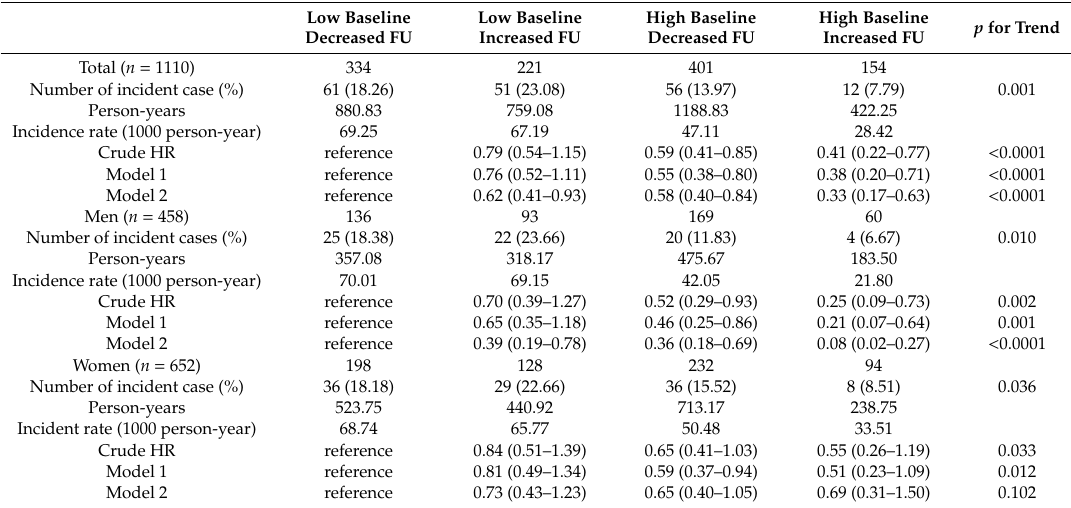
Table 2. Association between adiponectin concentrations and incidence of metabolic